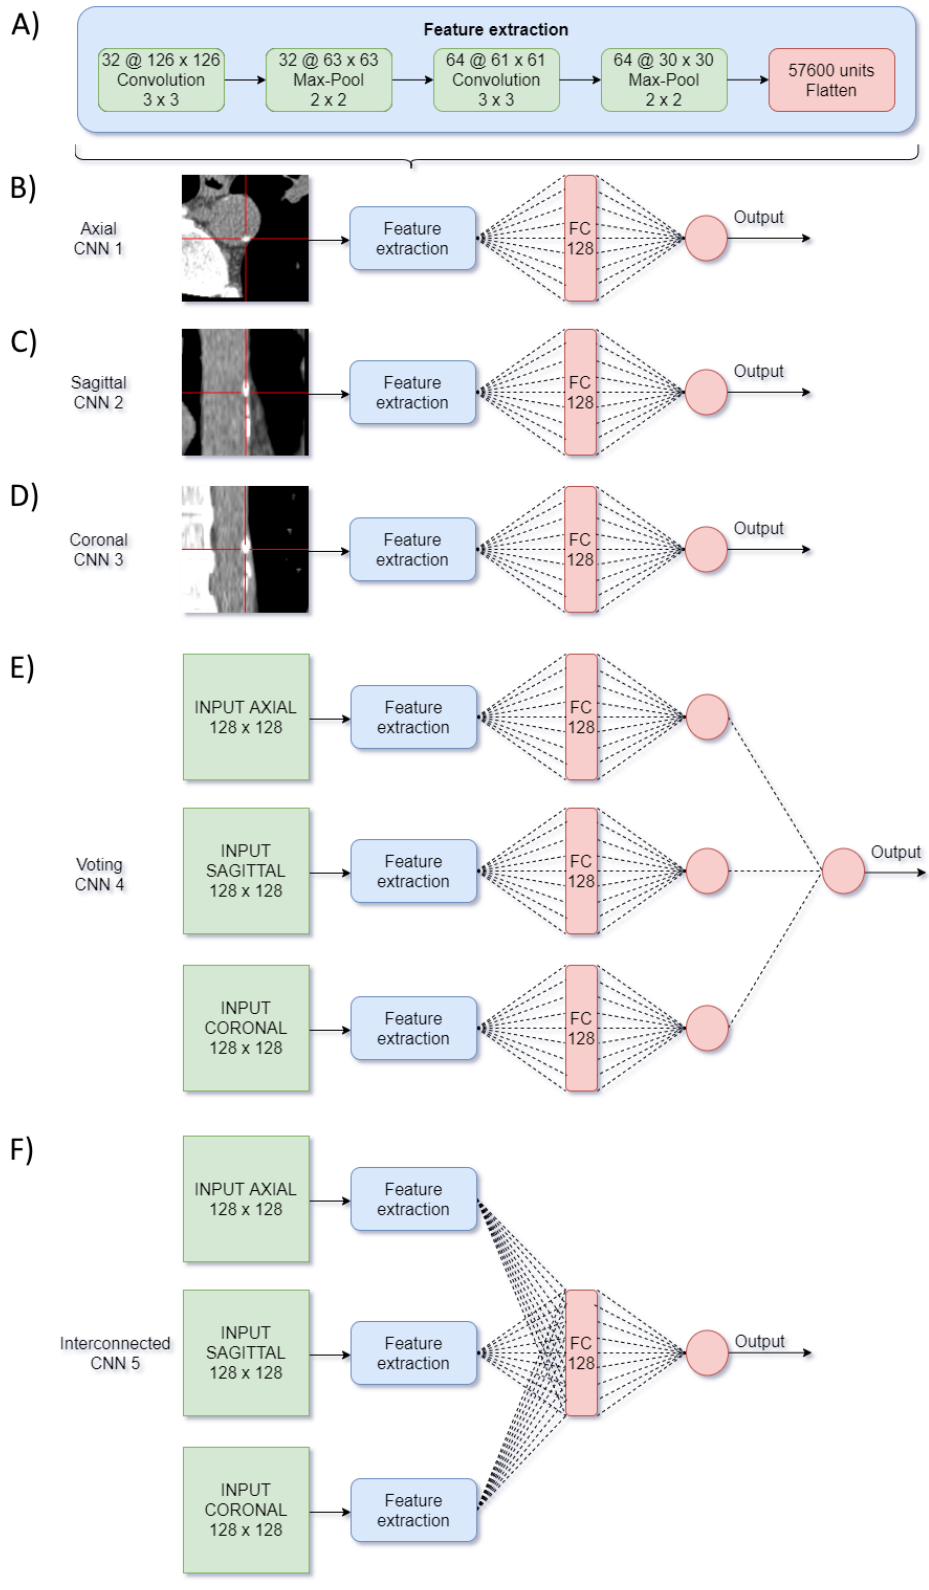
Figure 2. ( A ) Feature extraction block components. ( B – F ) CNN 1: Axial network. CNN 2: Sagittal network. CNN 3: Coronal network. CNN 4: Voting network. CNN 5: Interconnected